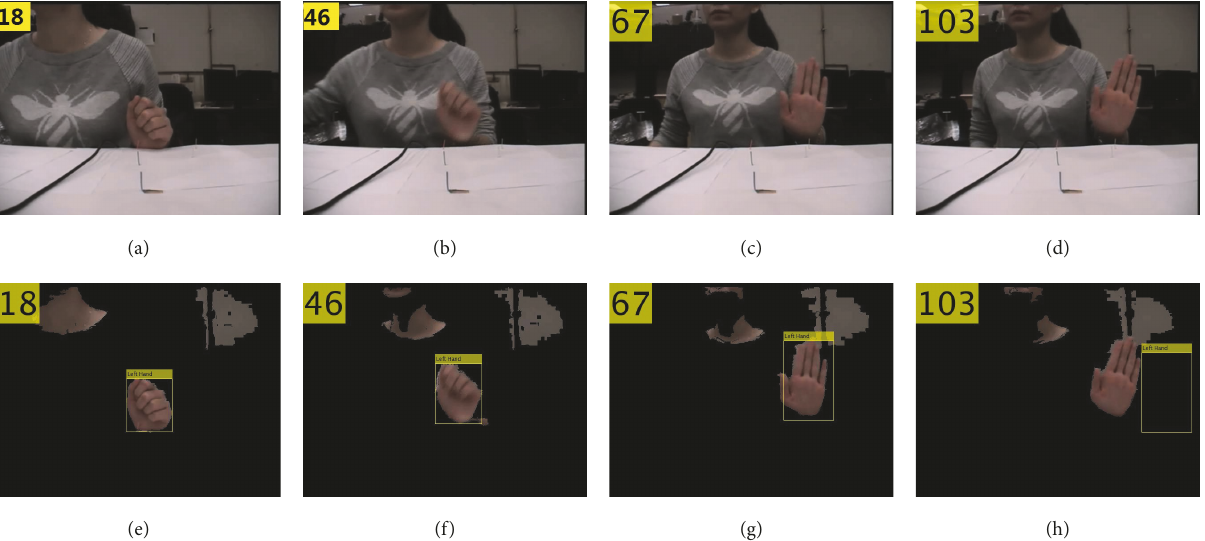
in (8) as the forcing term. This nonlinear force function can capture the complexities of motion patterns made by